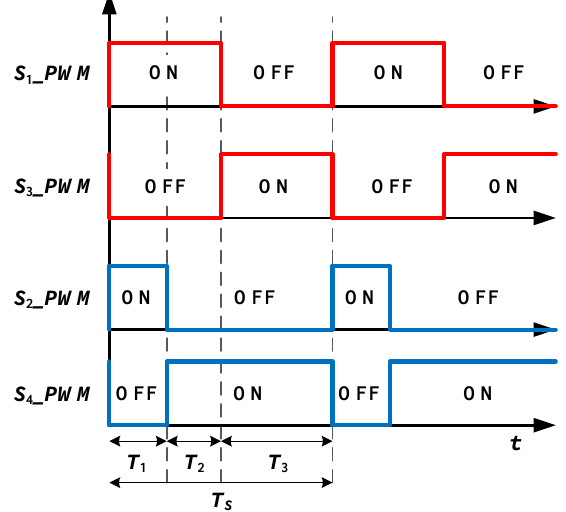
Figure 4. PWM signal waveforms of the power switches under the discharging scenario.